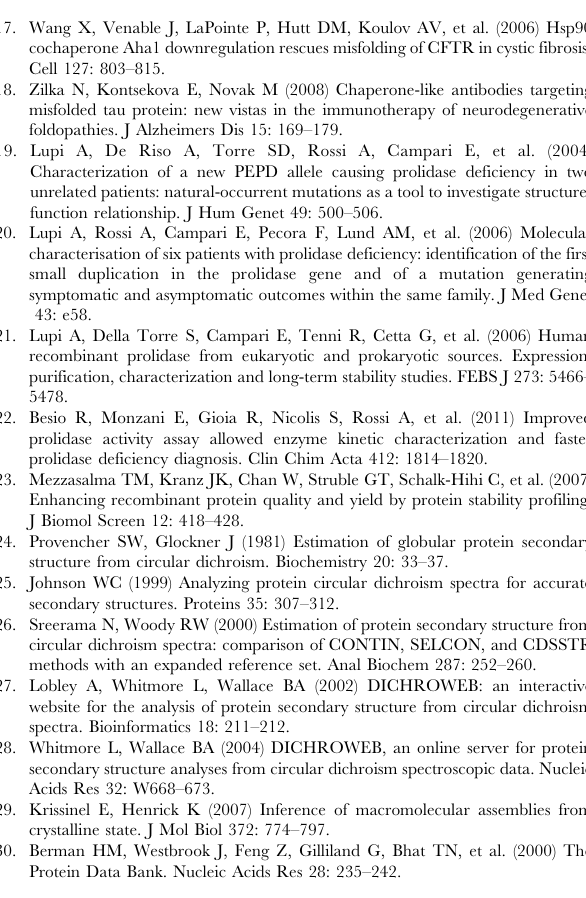
Table S1 Hydrodynamic radiuses of the recombinant prolidase variants observed with Dynamic Light Scat- tering. R h values and the percentages of polydispersion are reported as the averages of two independent experiments for each protein